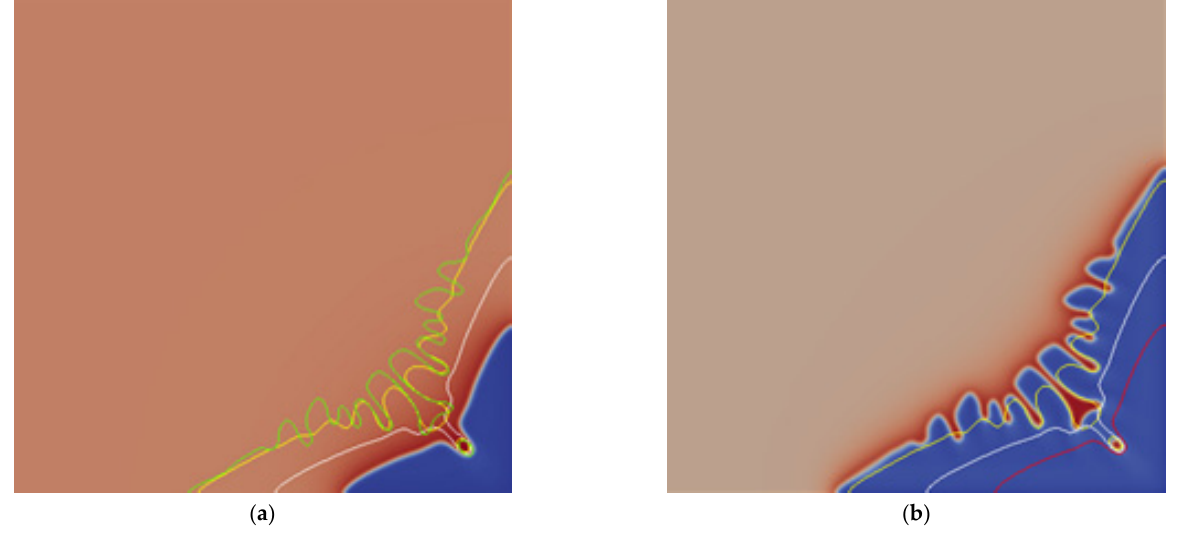
Figure 5. Solute-field diagram of dendrite morphology under different undercooling. ( a ) Solute-field diagram based on ∆𝑇 = 20𝐾 ; ( b ) Solute-field diagram based on ∆𝑇 = 35𝐾 , where the red line, white line, and yellow line and green line are the morphological contour lines of the dendrite when the undercooling is 20𝐾 , 25𝐾 , 30𝐾 , and 35𝐾 , respectively.